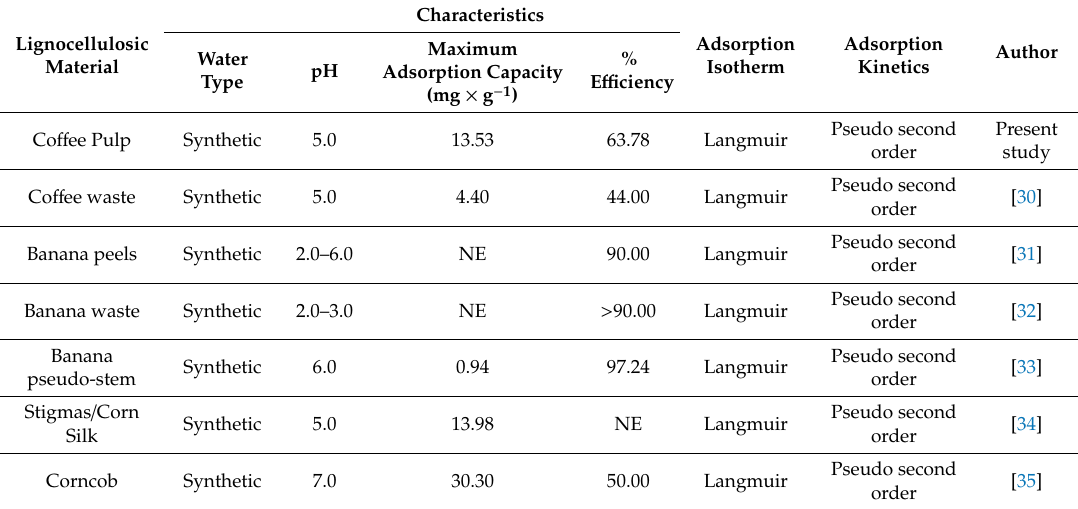
Figure 8. Adsorption isotherm for Zn(II) with CP. Table 4. Maximum adsorption capacity in agricultural wastes without chemical modification used for Zn(II) biosorption.